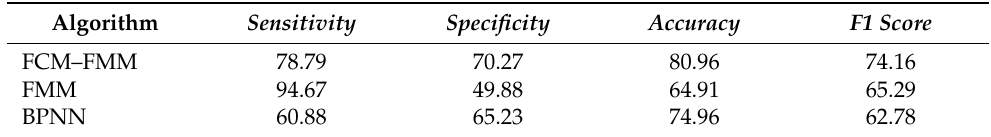
Table 3. Performance